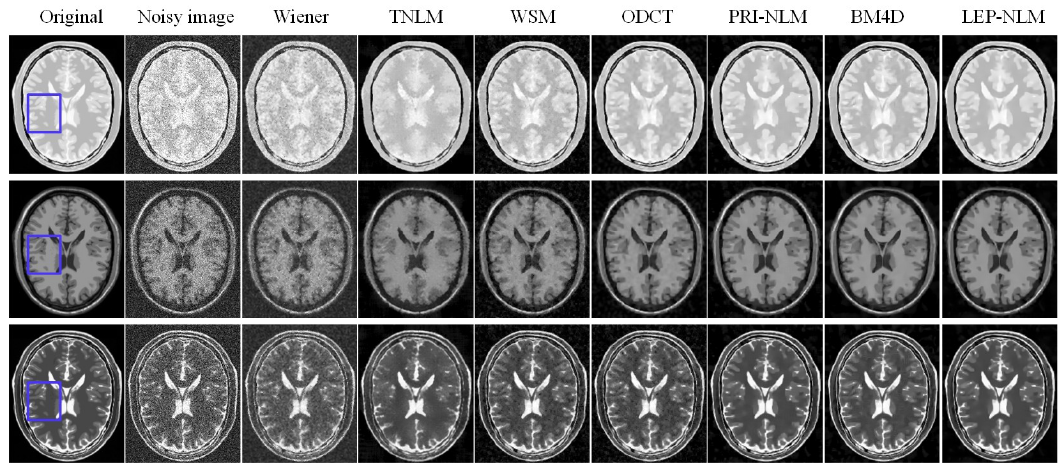
Figure 4. Visual inspection of the denoised results of Wiener, TNLM, WSM, ODCT, PRI-NLM, BM4D, and LEP-NLM filters on the BrainWeb phantom corrupted by the Rician noise level of 15%. The top row, middle row, and bottom row are the PD-weighted, T1-weighted, and T2-weighted MR images, respectively.